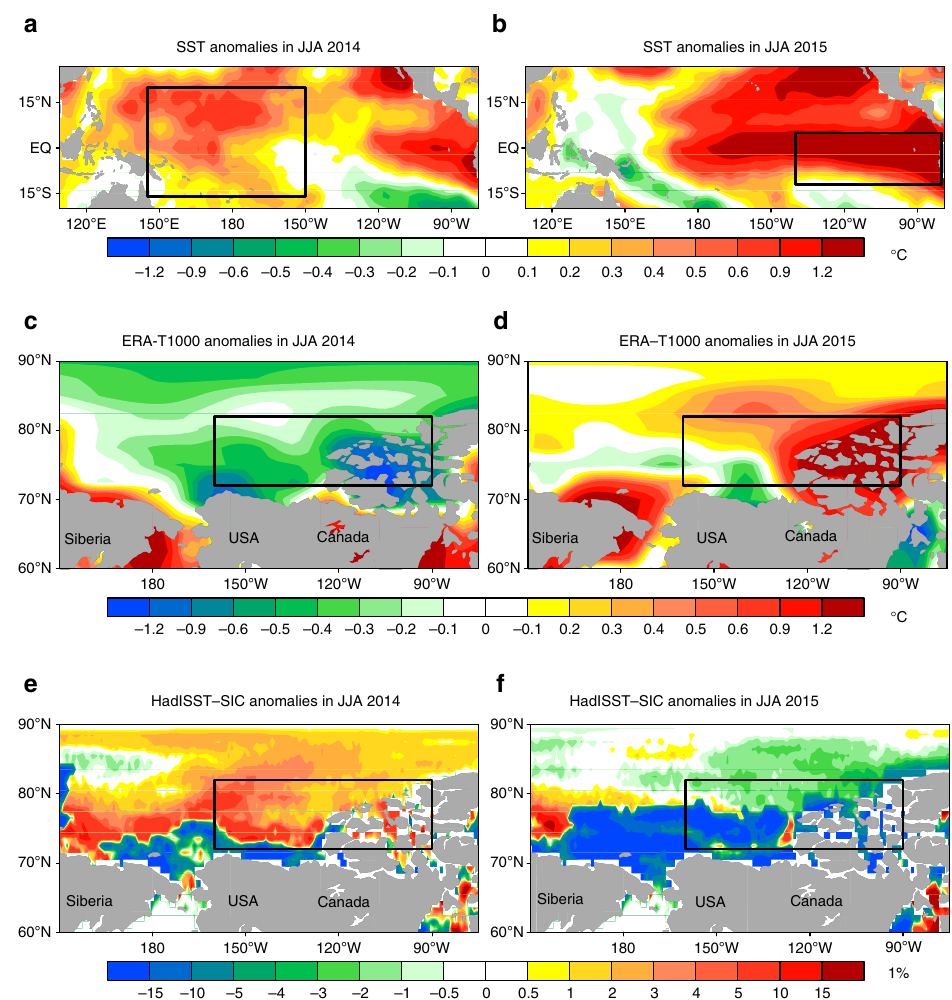
Figure 4 | Case verifications in JJA of 2014 and 2015. Shown in ( a , c , e ) are the SST, 1,000-hPa air temperature (ERA-Interim) and HadISST SIC anomalies in JJA of 2014, respectively. ( b , d , f ) are the same as in a , c , e , except for JJA of 2015. The boxes in a , b outline the CP region (140 (cid:2) W–80 (cid:2) W, 12 (cid:2) S–5 (cid:2) N) and the EP region (145 (cid:2) E–150 (cid:2) W, 16 (cid:2) S–20 (cid:2) N), respectively. The boxes in c – f mark the same region (160 (cid:2) W–90 (cid:2) W, 72 (cid:2) N–82 (cid:2)